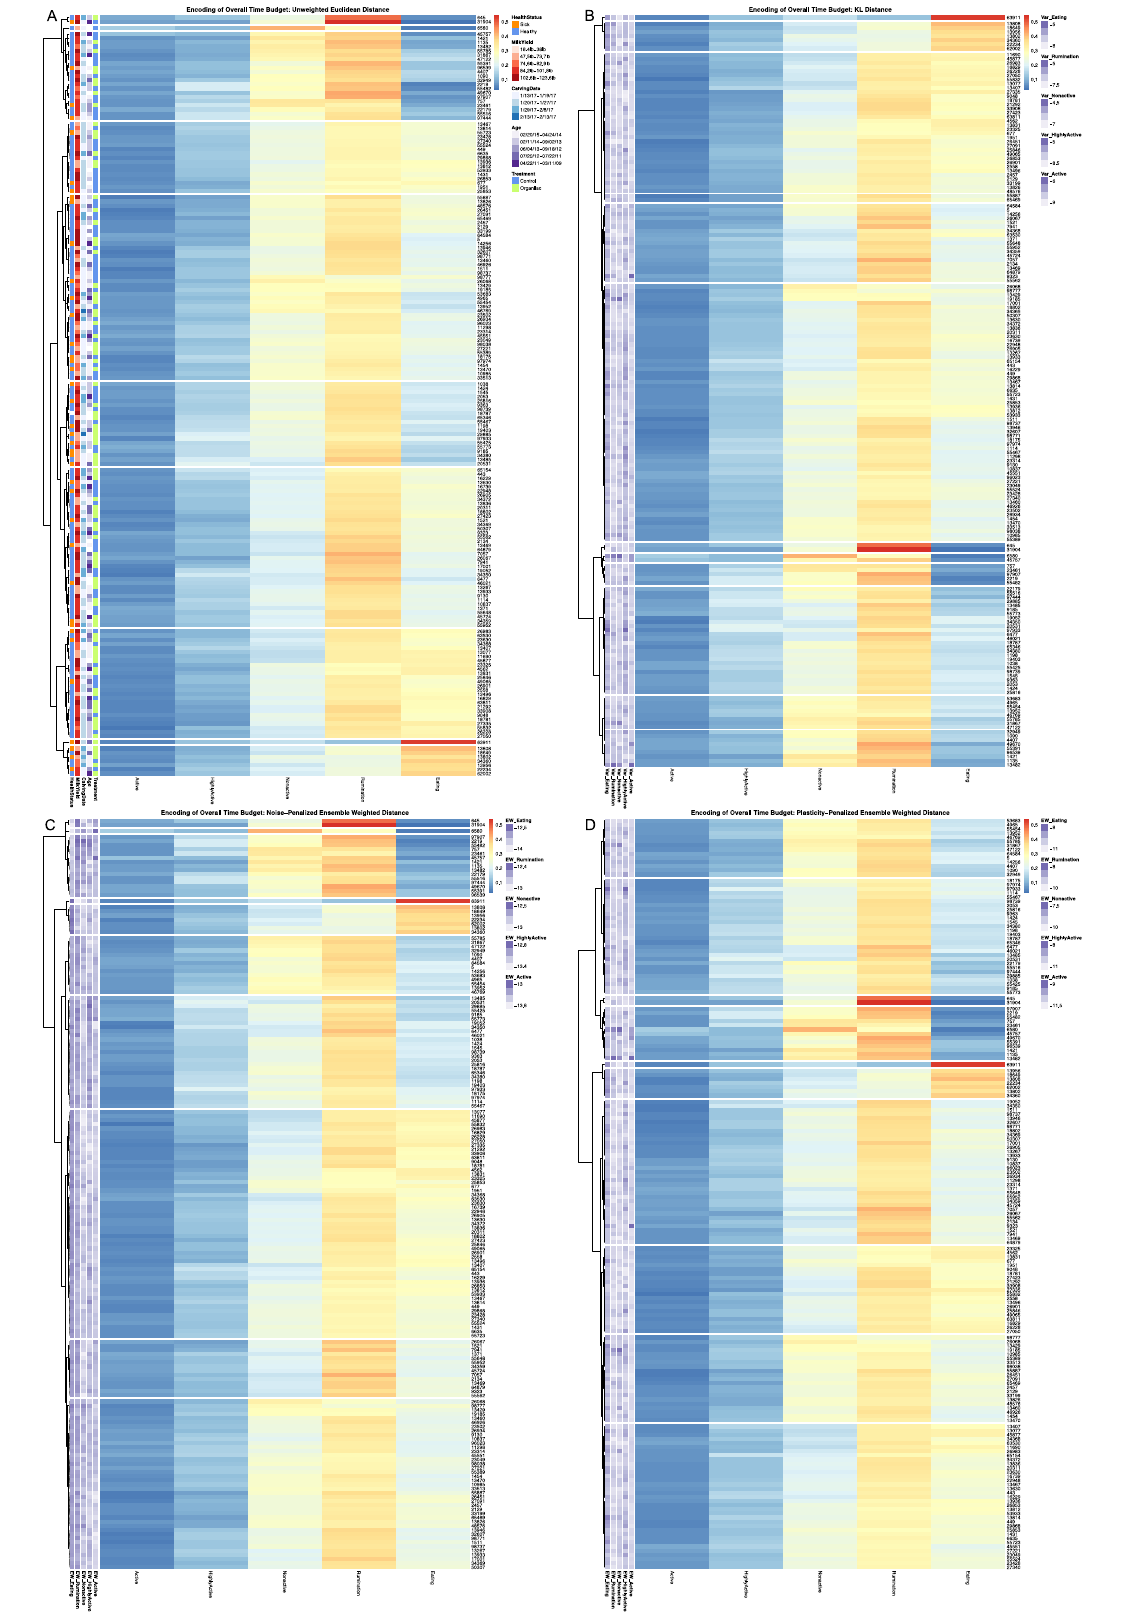
Figure 2. Comparison of overall time budget encodings derived from different dissimilarity